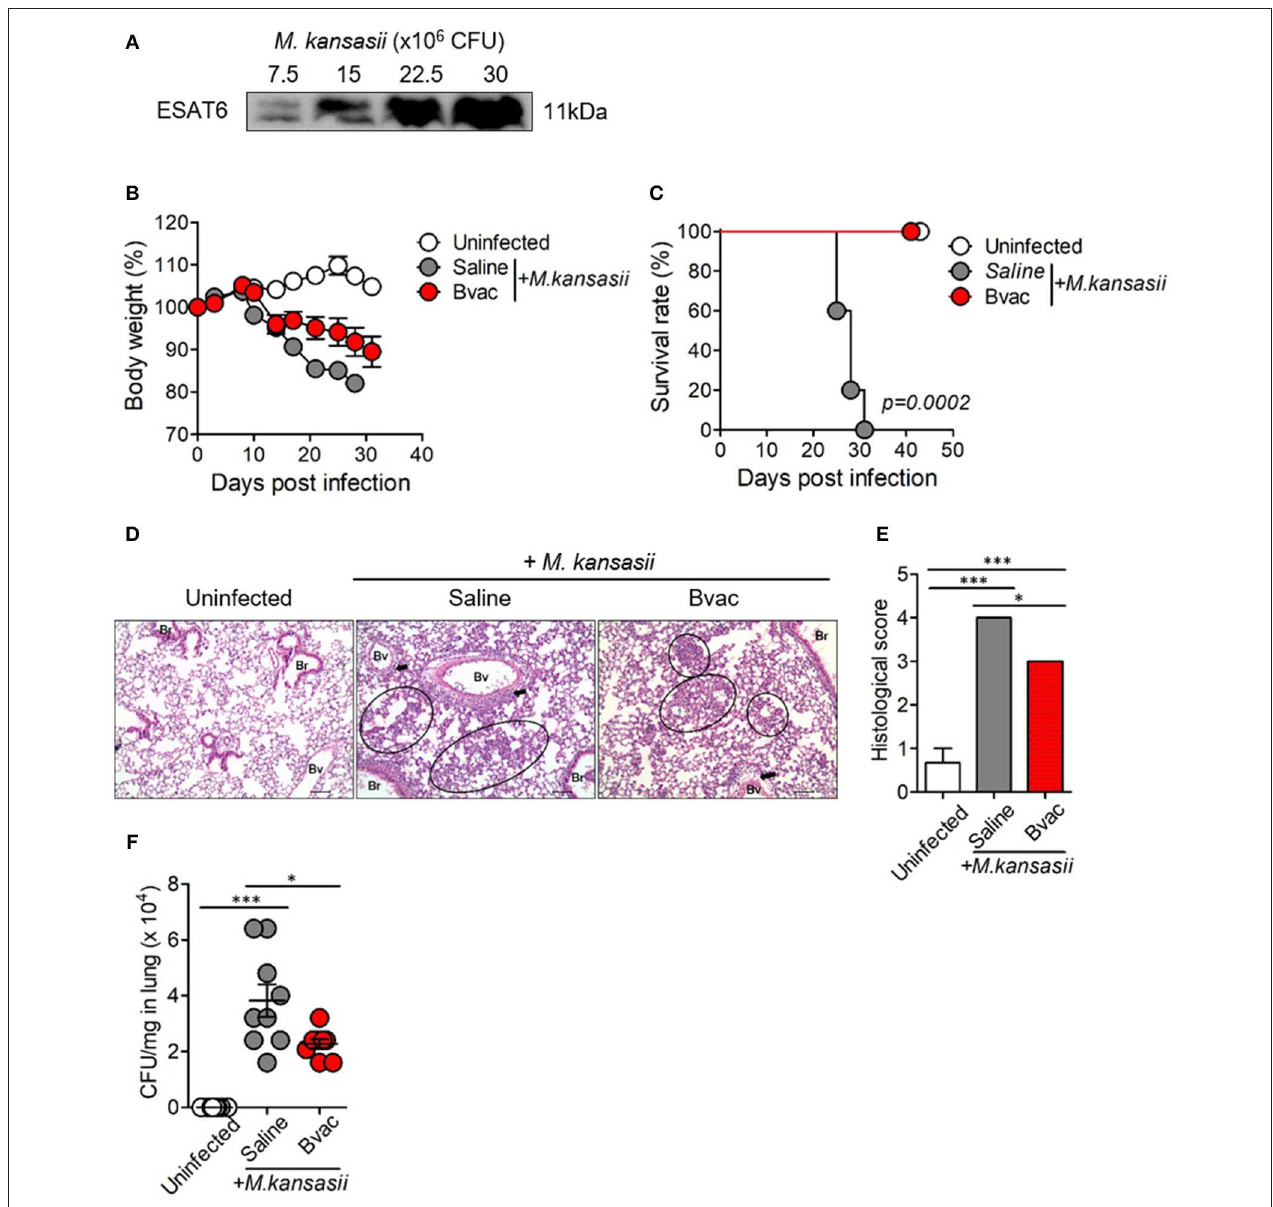
FIGURE 3 | Immunization of mice with Bvac prevented M. kansasii infection. (A) Expression of 11 kDa ESAT6 obtained from lysates of various CFU of M. kansasii by western blotting. (B–F) Mice were intravenously immunized with Bvac via tail vein. After 14 days of immunization mice were challenged with M. kansasii (10 7 CFU/mouse) ( n = 5 for uninfected, n = 6 for saline and Bvac group). After 14 days following M. kansasii infection, histology and bacterial CFU were determined from lungs. (B) Bodyweight. ANOVA. * p < 0.05, M. kansasii vs. Bvac + M. kansasii. (C) Survival rate. Log-rank test. (D) Representative hematoxylin and eosin staining of lung sections from each group of mice (scale bar = 100 µ m). Bv (Blood vessel), Br (Bronchus), circle indicates interstitial necrotizing inflammatory foci, and arrow is perivascular inflammatory cell infiltration. (E) Histological scores of the lung sections. (F) CFU of M. kansasii from lung homogenates. ANOVA. * p < 0.05, *** p <